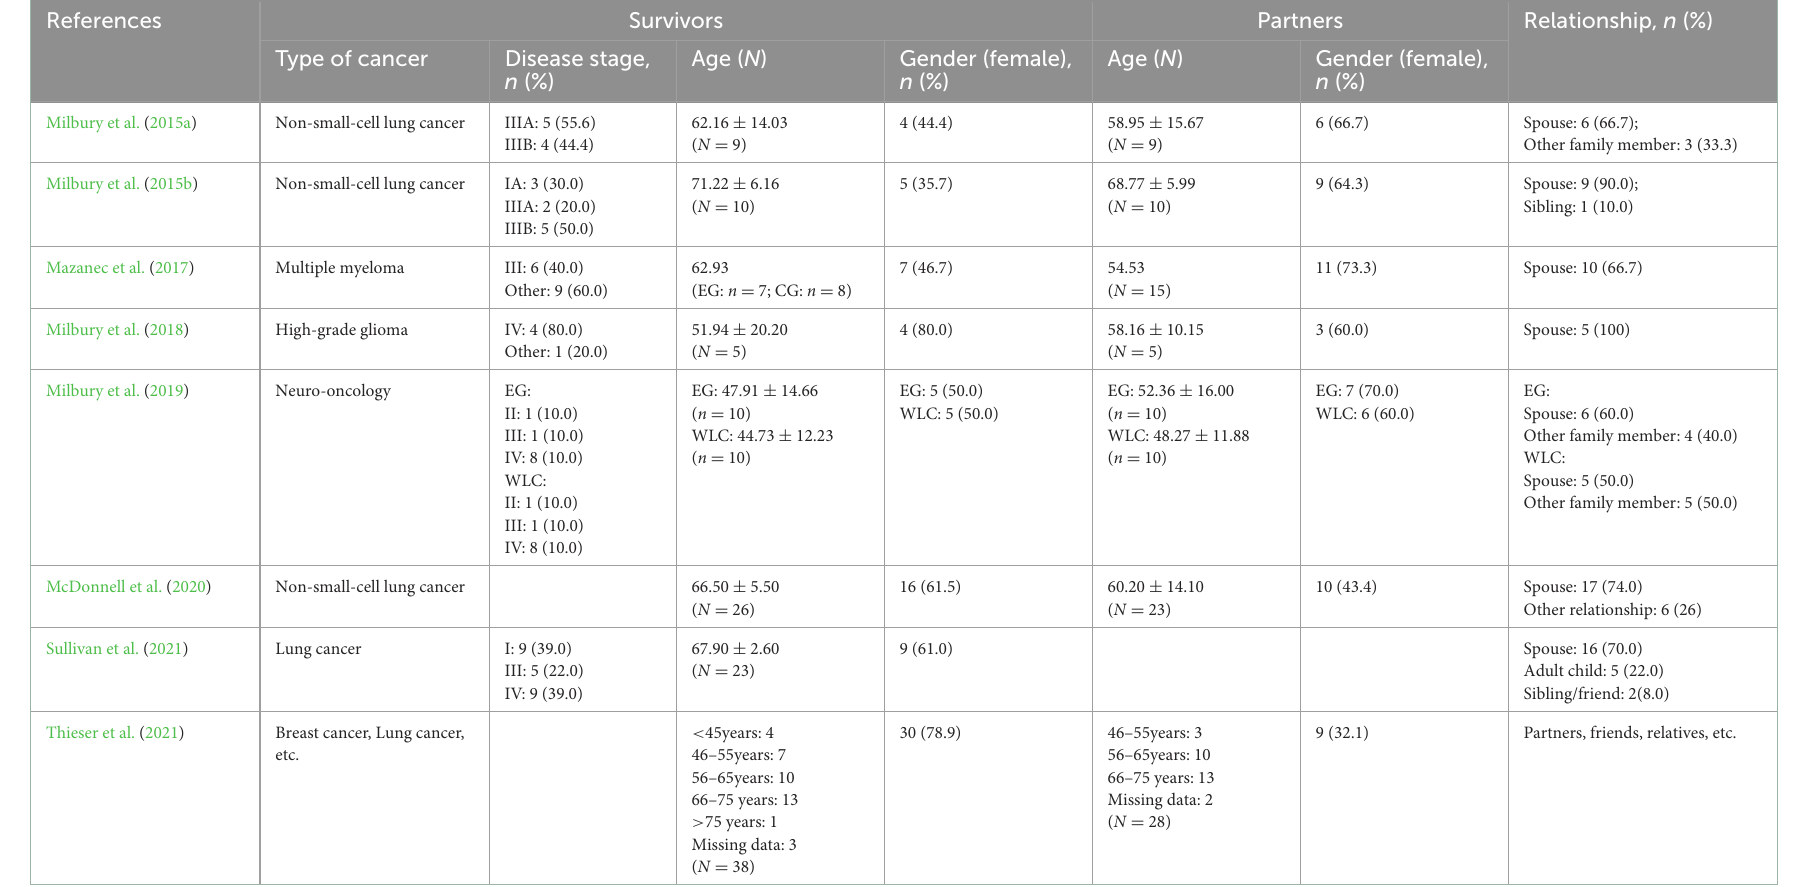
TABLE 1 Characteristics of study